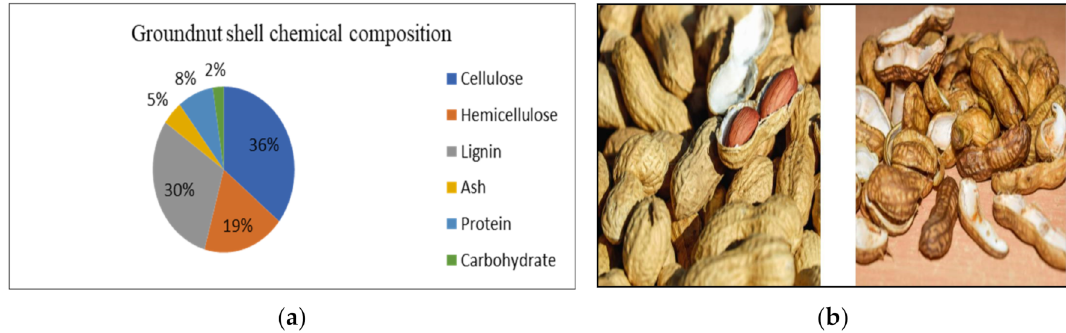
Figure 33. ( a ) Groundnut shell chemical composition ( b ) groundnut and shell.